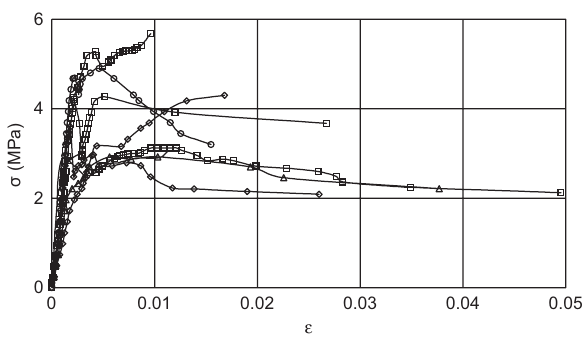
Figure 10 Axial stress vs. axial strain of freshly quarried Kenchreae stone specimens subjected to compression.